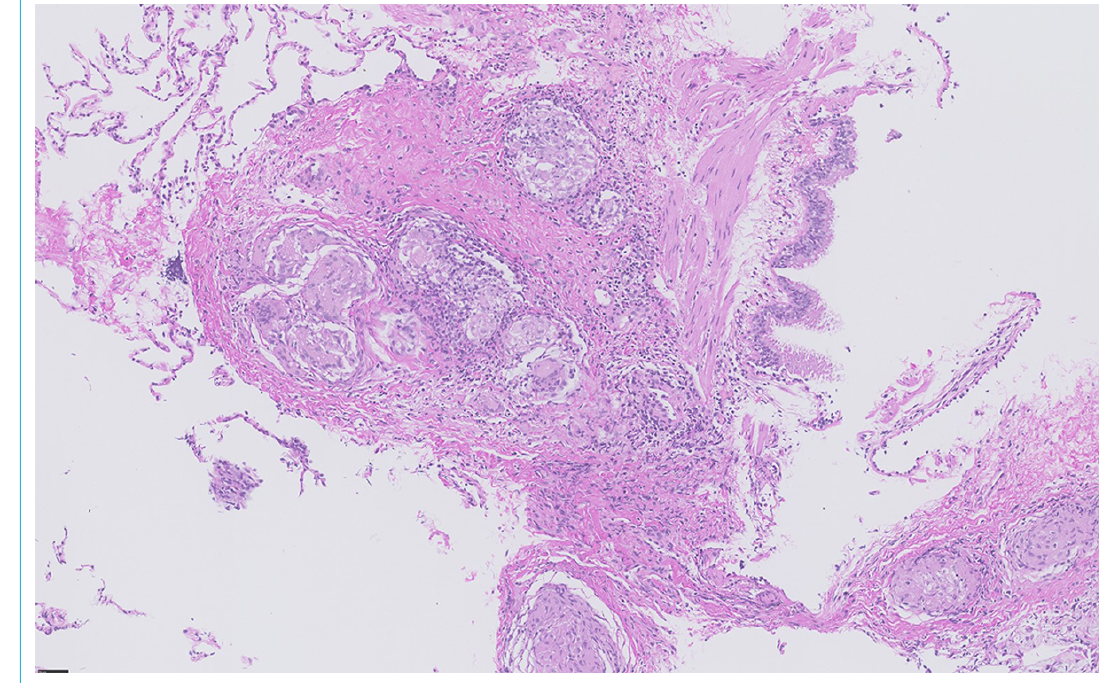
Figure 1: Transbronchial biopsy showing multiple non-necrotising granulomas situated in close proximity to the bronchial mucosa (bron- chovascular distribution) (courtesy Dr Bart Vrugt, Cantonal Hospital